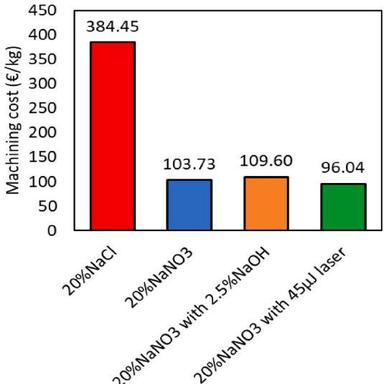
Machining cost analysis for processing NbC–Ni cermet with ECM in different electrolytes and LECM.